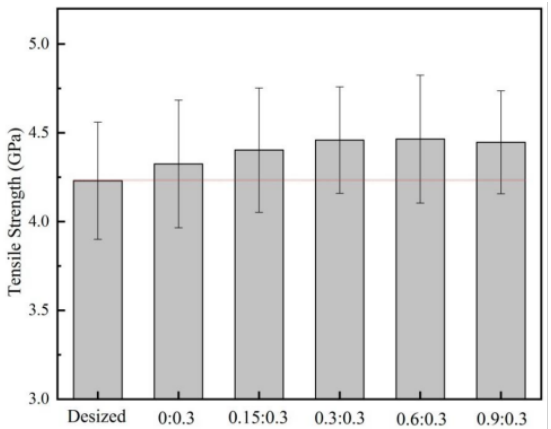
Figure 10. Single-filament tensile strength test of CNTs/CF multiscale reinforcements prepared under different growth atmospheres. The moving speed of carbon fibers was 4 cm/min.